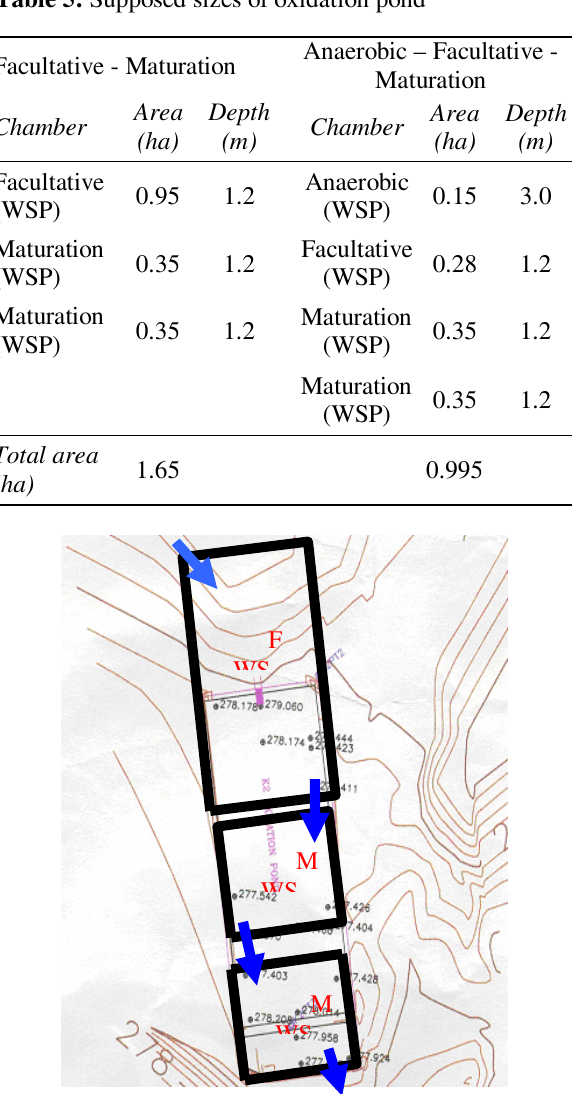
Table 5: Supposed sizes of oxidation pond